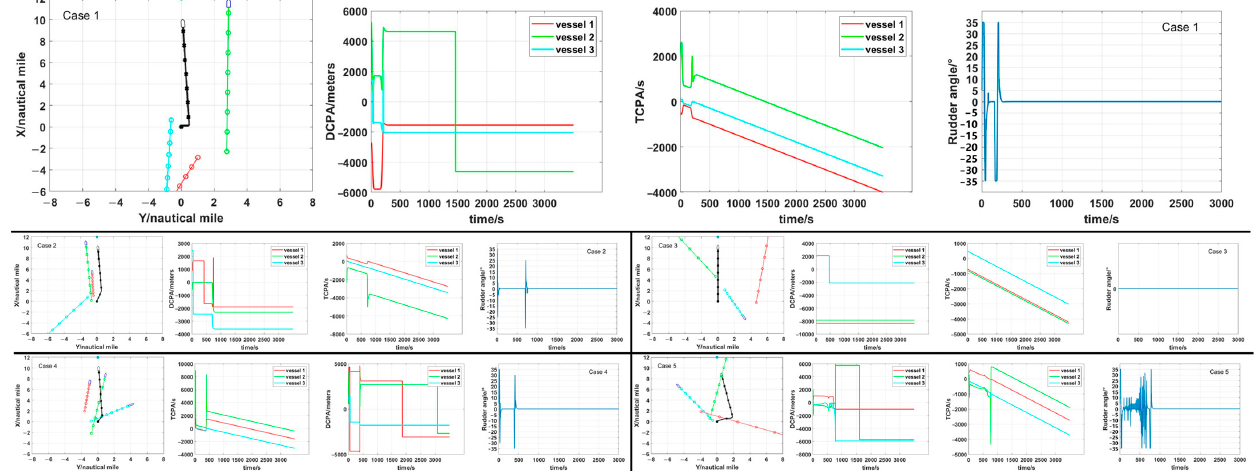
Figure 18. Test samples in generated virtual scenarios of 3 target ships encounter. There are 5 cases illustrated in the plots (case 1 in the larger graphs, other cases in the smaller graphs), in each case, the DCPA, TCPA and rudder angle changings are also added.